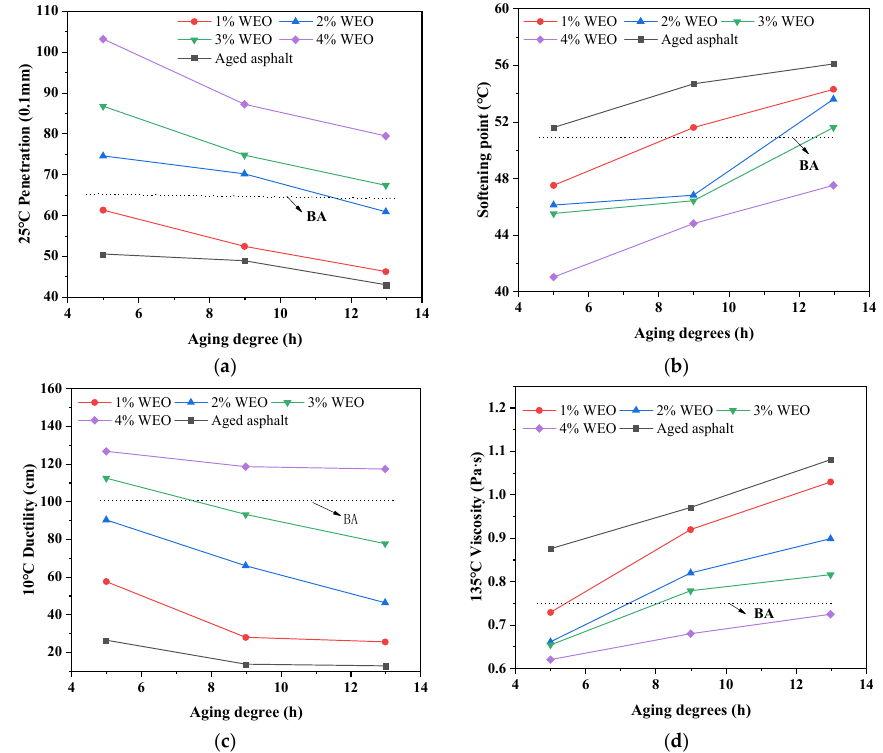
Figure 5. Test results of different indexes of asphalt. ( a ) Penetration. ( b ) Softening point. ( c ) Ductility. ( d ) 135 ◦ C